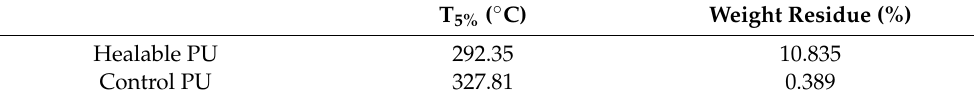
Table 4. Overview of T 5% and weight residue at 600 ◦ C for the bio-based 2K PU coatings.